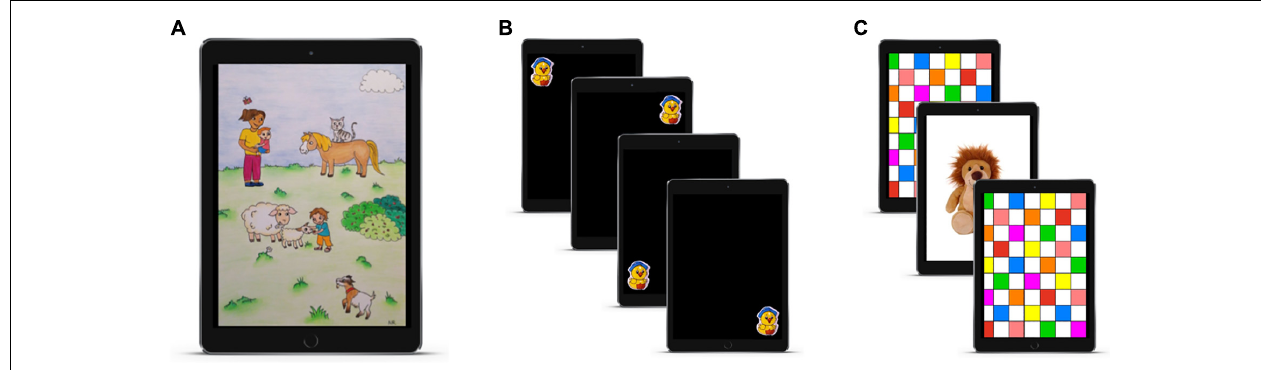
FIGURE 2 | Illustration of the individual experimental steps as displayed in the App, including (A) the production phase, (B) the calibration phase, and (C) an example of two experimental trials separated by an attention getter.